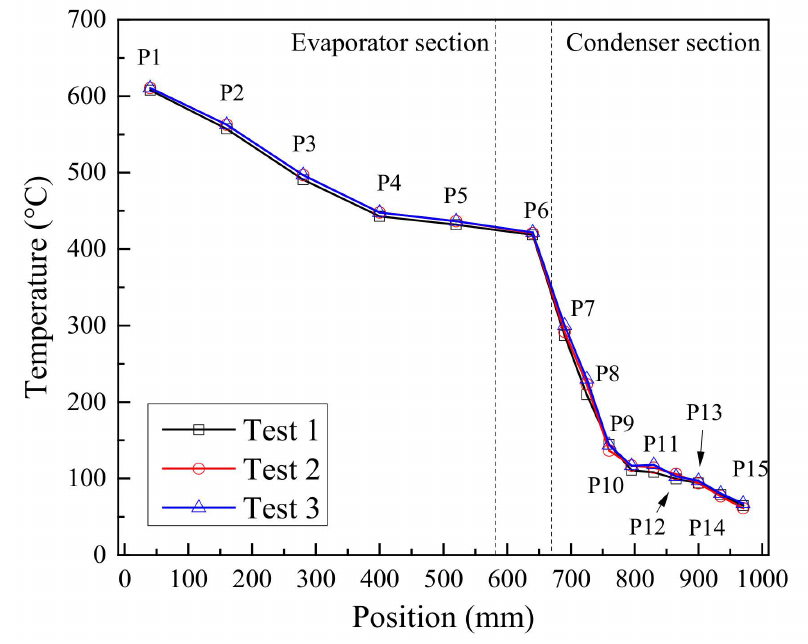
Figure 4. Reproducibility of time-average wall temperature of Na-K alloy heat